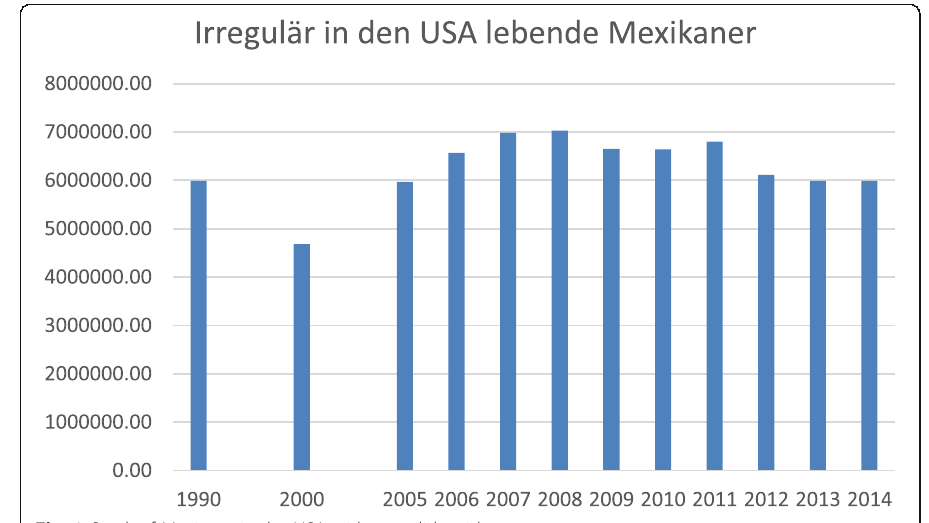
Fig. 2 Stock of Mexicans in the USA without valid residence